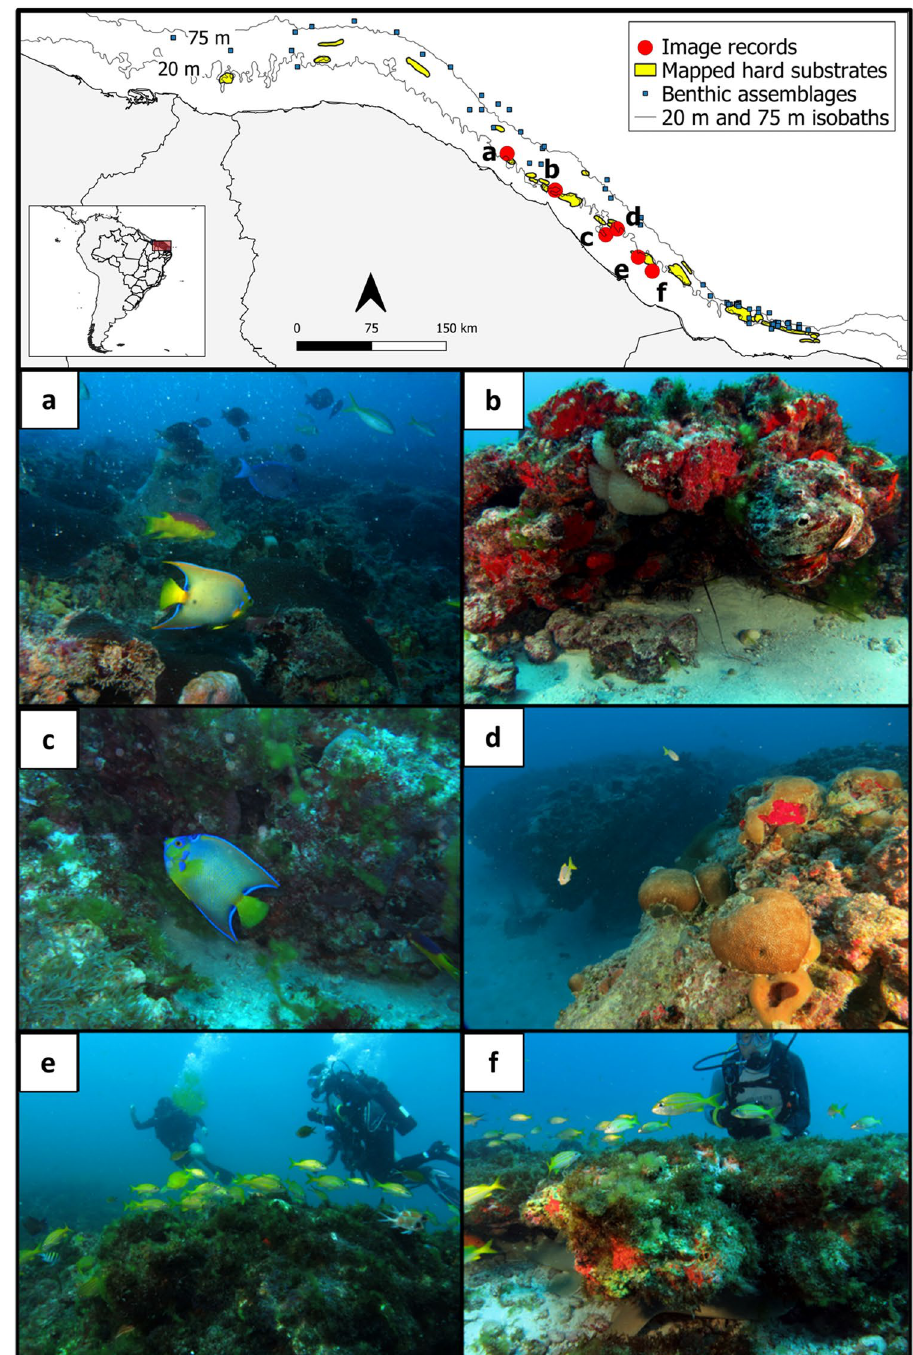
Figure 3. Reefal environments on the continental shelf off the Brazilian semi-arid coast. ( a ) “Manoel Salvador” reef (~ 30 m deep) covered by Montastraea cavernosa , ( b ) “Pedrinha” (~ 17 m) with sponges, ascidians, and calcareous algae, ( c ) reef fish ( Holacanthus ciliaris ) on the “Cabeço Seco” (~ 13 m) ( d ) “Canal do Uruaú” mesophotic reef (~ 34 m) with large Siderastrea spp. coral colonies, ( e ) “Pedra Grande da Majorlandia” (~ 16 m) covered by fleshy algae, and ( f ) “Pedra Preta” (~ 13 m) covered by fleshy and calcareous algae. Map made using QGIS 3.22 (https:// qgis. org/). Bathymetric data retrieved from CPRM (https:// www. cprm. gov. br/) and country area from GADM (https:// gadm.